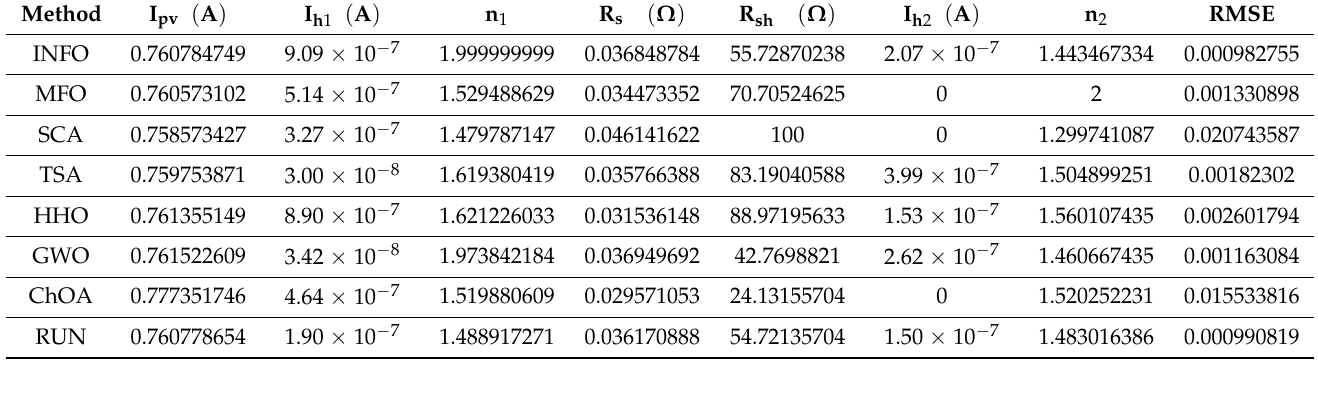
Table 4. The DDMSC’s identified parameters at the best RMSE.